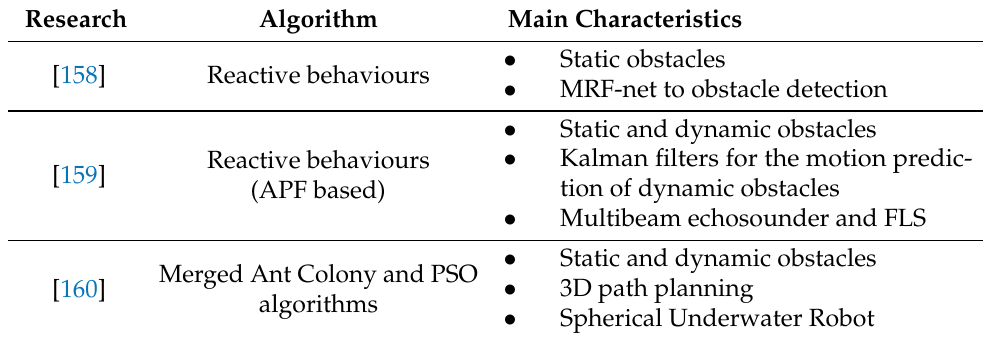
Table 9. List of algorithms in real applications from